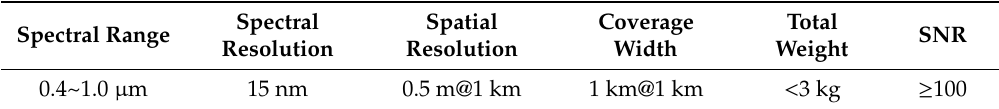
Table 1. Specifications of the spectrometer. The signal-to-noise ratio (SNR) is meaningful only at a given reference radiance, which is provided by the application.